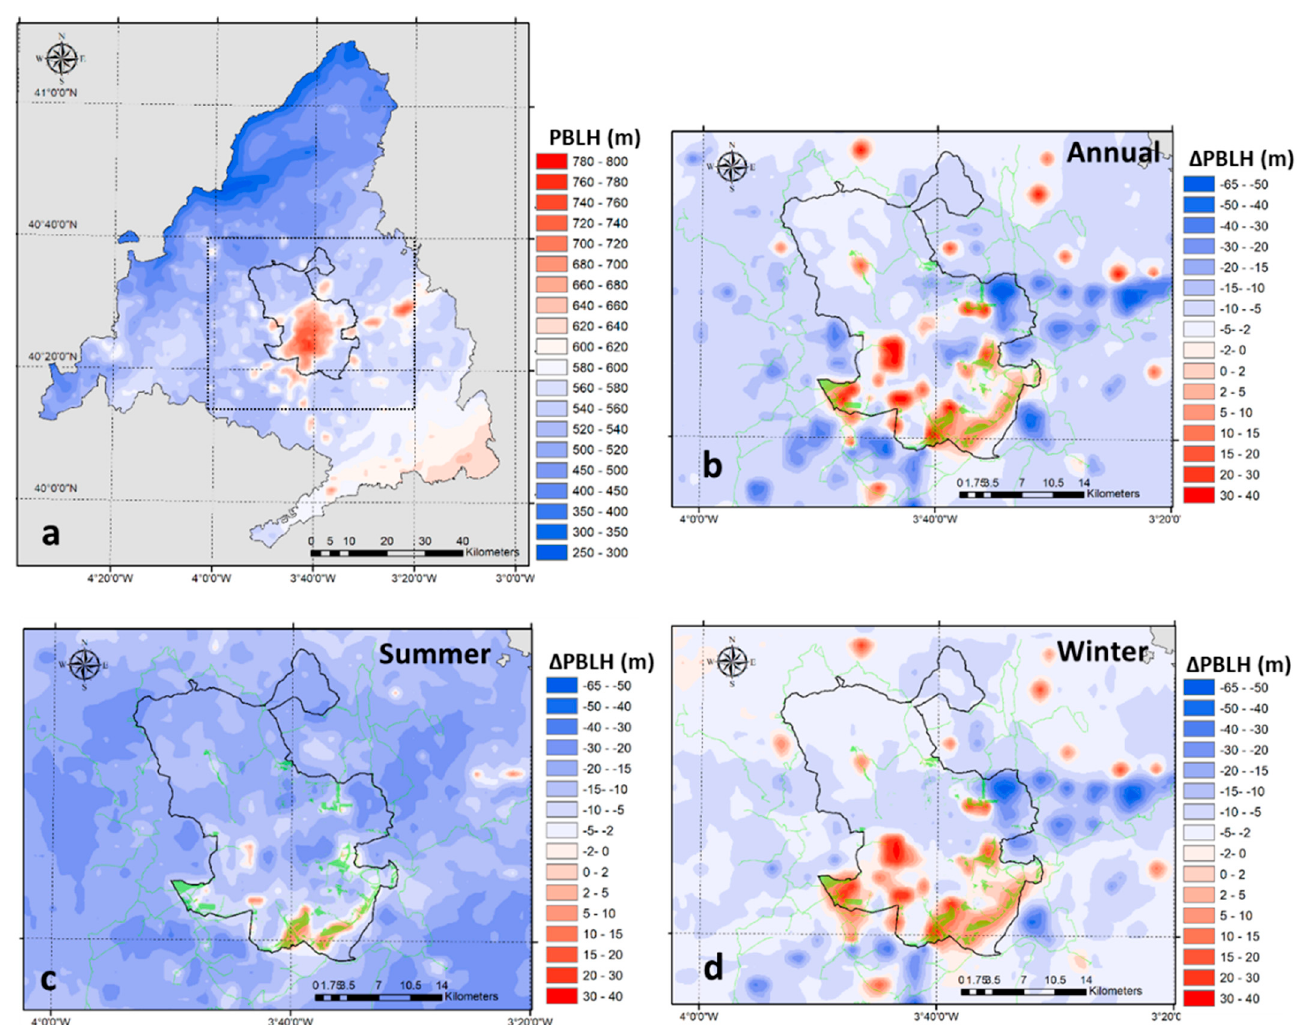
Figure 6. Annual planetary boundary layer height (PBLH) for the Baseline Scenario ( a ). Expected variation of PBLH: annual mean ( b ), summer mean ( c ) and winter mean ( d ), due to future vegetation.